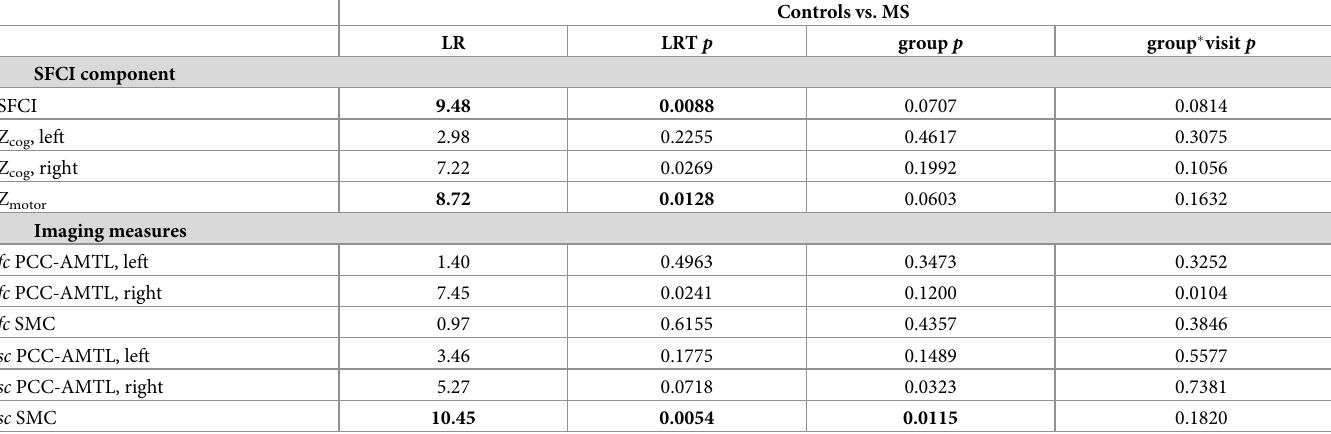
Table 3. Results of the LRT for group differences from baseline to the final visit in SFCI components and associated measures.